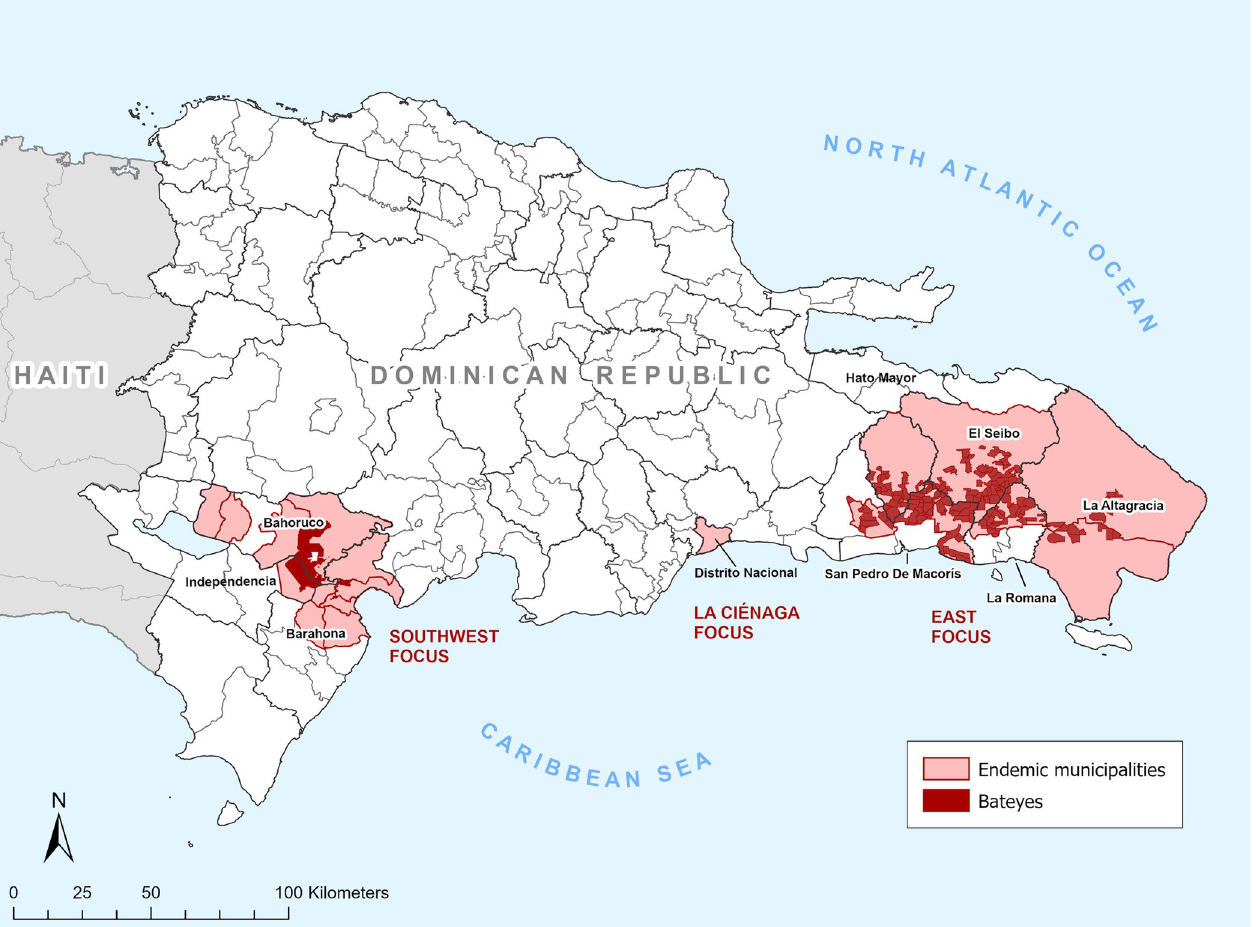
Fig 1. Map of the Dominican Republic showing LF-endemic areas (dark red) and associated municipalities (light red) identified from baseline mapping. The map was created using ArcGIS Pro version 2.8.1. No baselayer was used in the map. The source of the shapefiles is the Oficina Nacional de Estadı´stica (ONE) of the Dominican